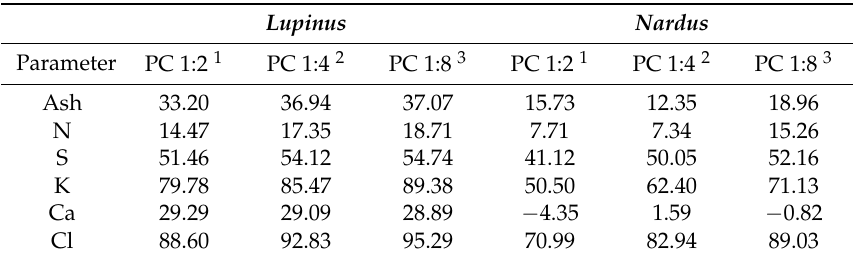
Table A2. Rate of reduction (%) of concentrations of Ash, N, S, K, Ca and Cl from biomass DM to press cake DM achieved in Experiment 2.